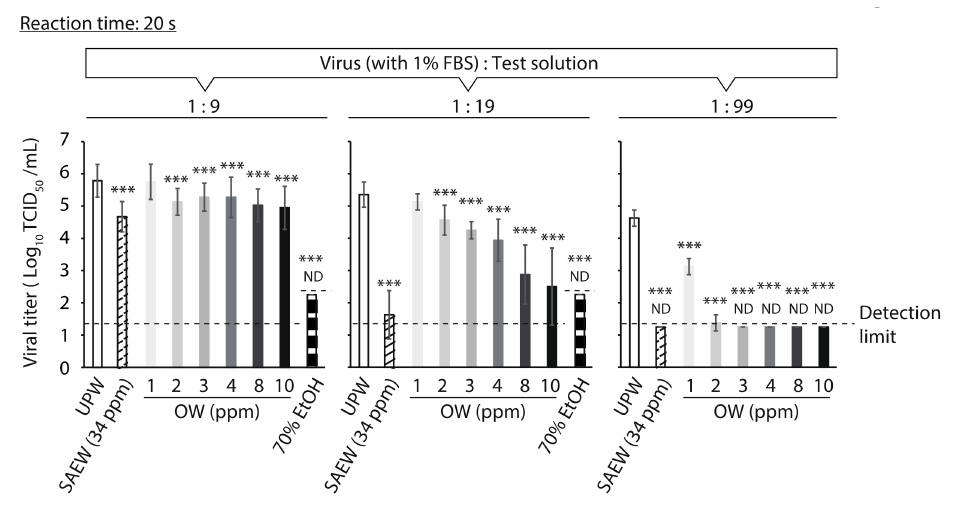
Figure 1. Comparison of virucidal activities of slightly acidic electrolyzed water (SAEW), ozonated water (OW) and 70% ethanol (EtOH). The viral titer of each reaction mixture was measured. Results are indicated as mean ± standard deviation ( n = 3–30 per group). The detection limits of the viral titer are 1.25 log 10 50% tissue culture infective dose (TCID 50 )/mL in the ultra-pure water (UPW), SAEW and OW groups, and 2.25 log 10 TCID 50 /mL in the 70% EtOH group. ND is the abbreviation for not detected, which means that the viral titer was below the detection limit. Student’s t -test was performed to analyze the statistical significance between the UPW (control) group and each test solution group; *** p < 0.001. FBS, fetal bovine